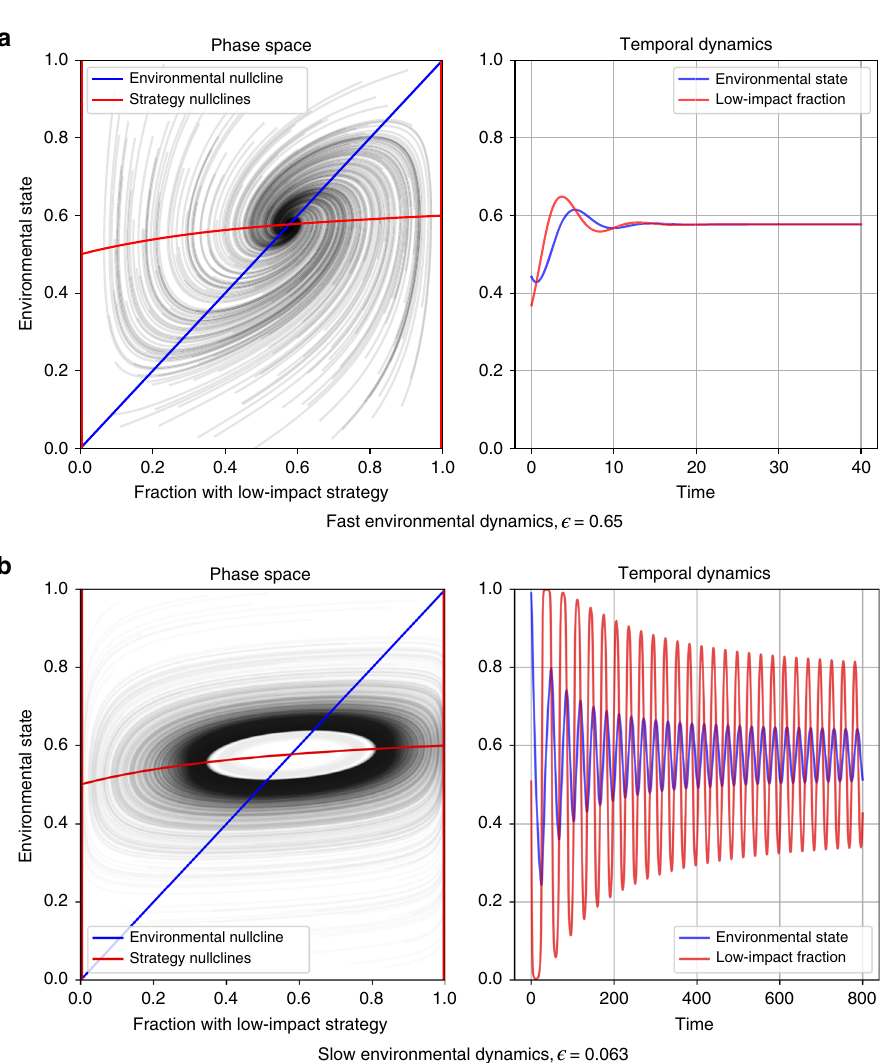
Fig. 3 Phase planes and temporal dynamics in eco-evolutionary games with a decaying resource. Parameters are chosen to fall in the yellow region of Fig. 2b. Only the speed of environmental dynamics relative to strategy dynamics, ϵ , varies between the panels. a Convergence to an interior equilibrium occurs for high ϵ . b Convergence to a limit cycle occurs for low ϵ . ( α ¼ 1 ; Δ 1